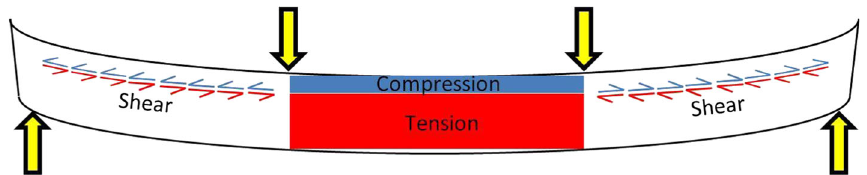
Fig. 2 Internal stress distribution in third-point bending.